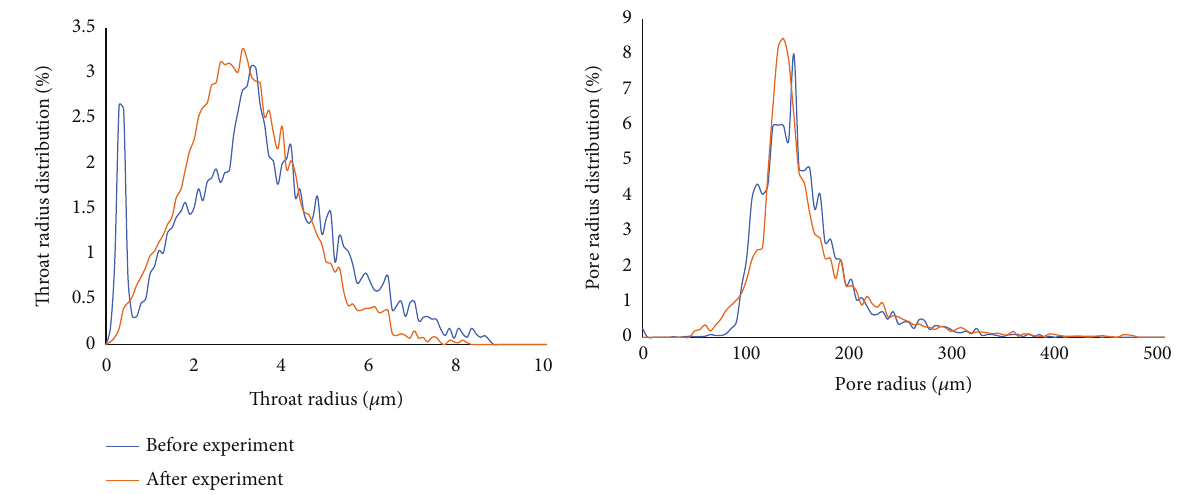
Figure 9: D1 distribution of pore and throat before and after core